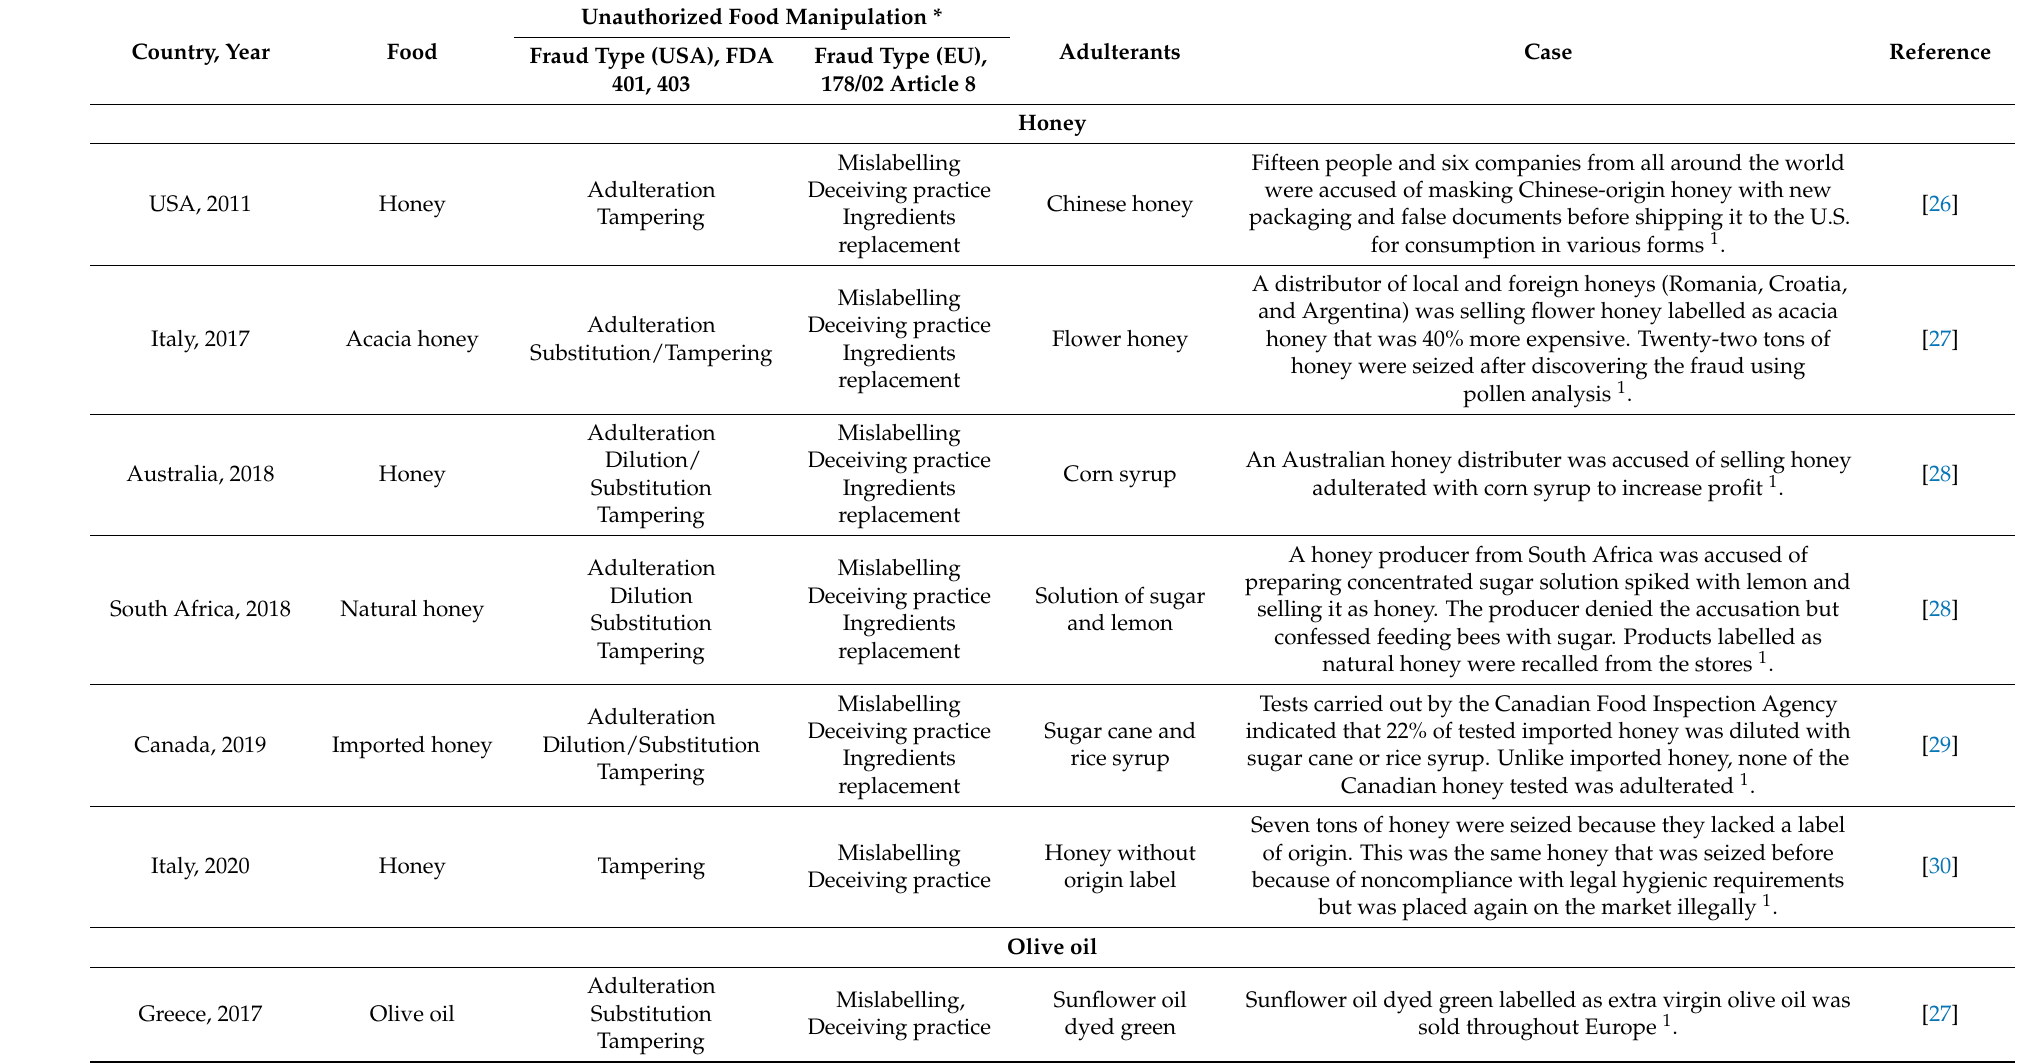
Table 1. Unauthorized food manipulation regarding food fraud cases,